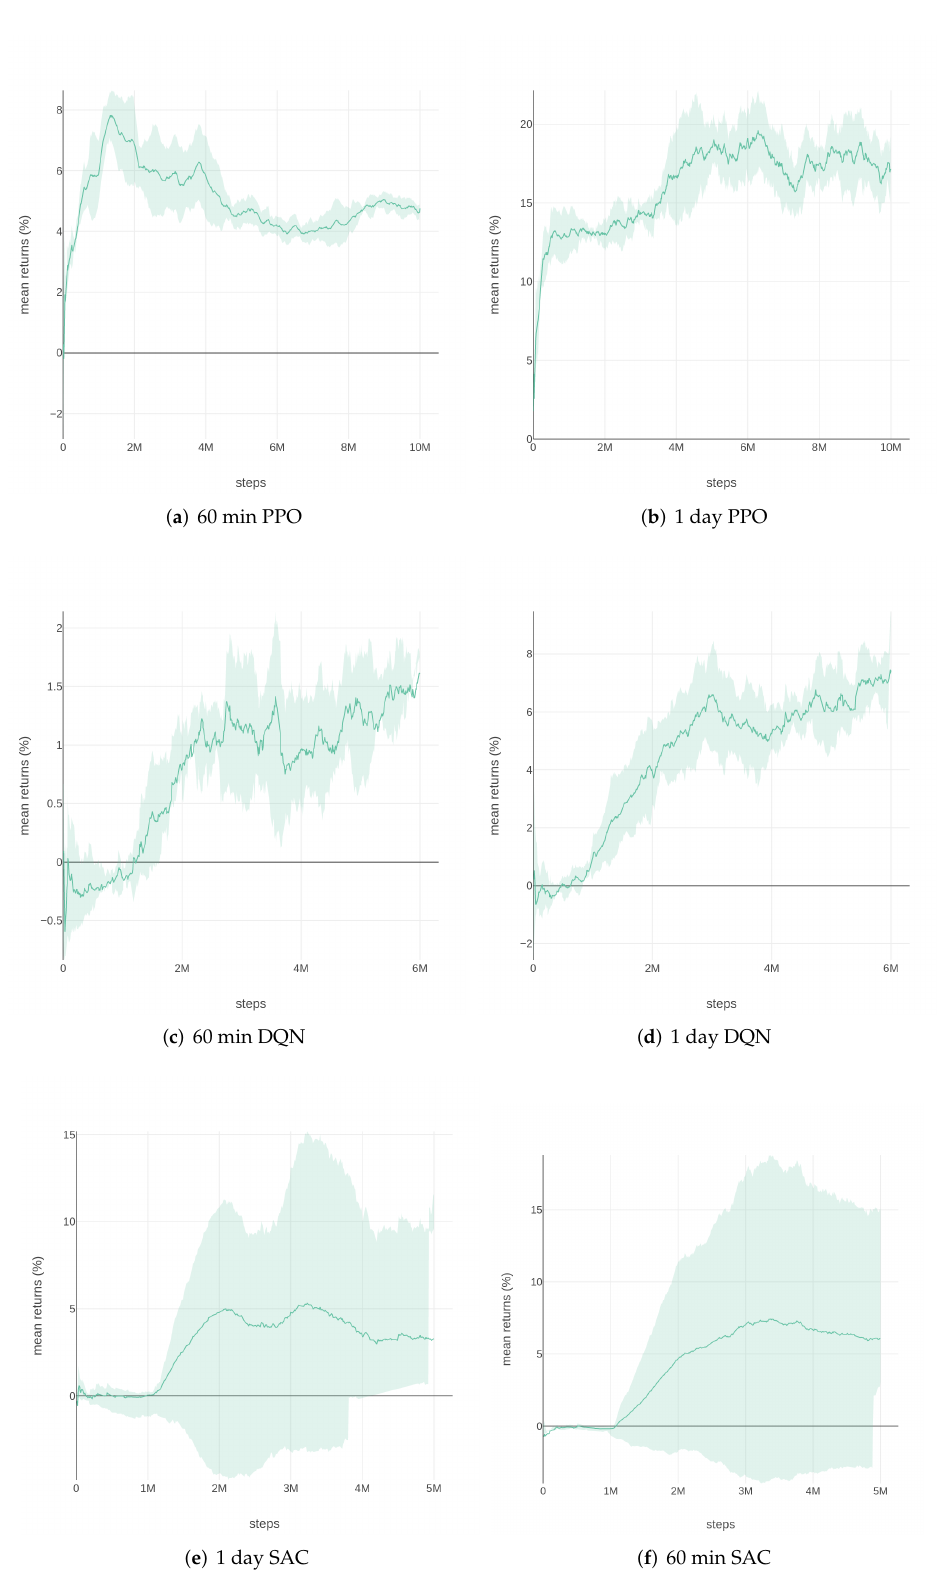
Figure 4. Training results on 50 ETF in two different time intervals using PPO, DQN, and